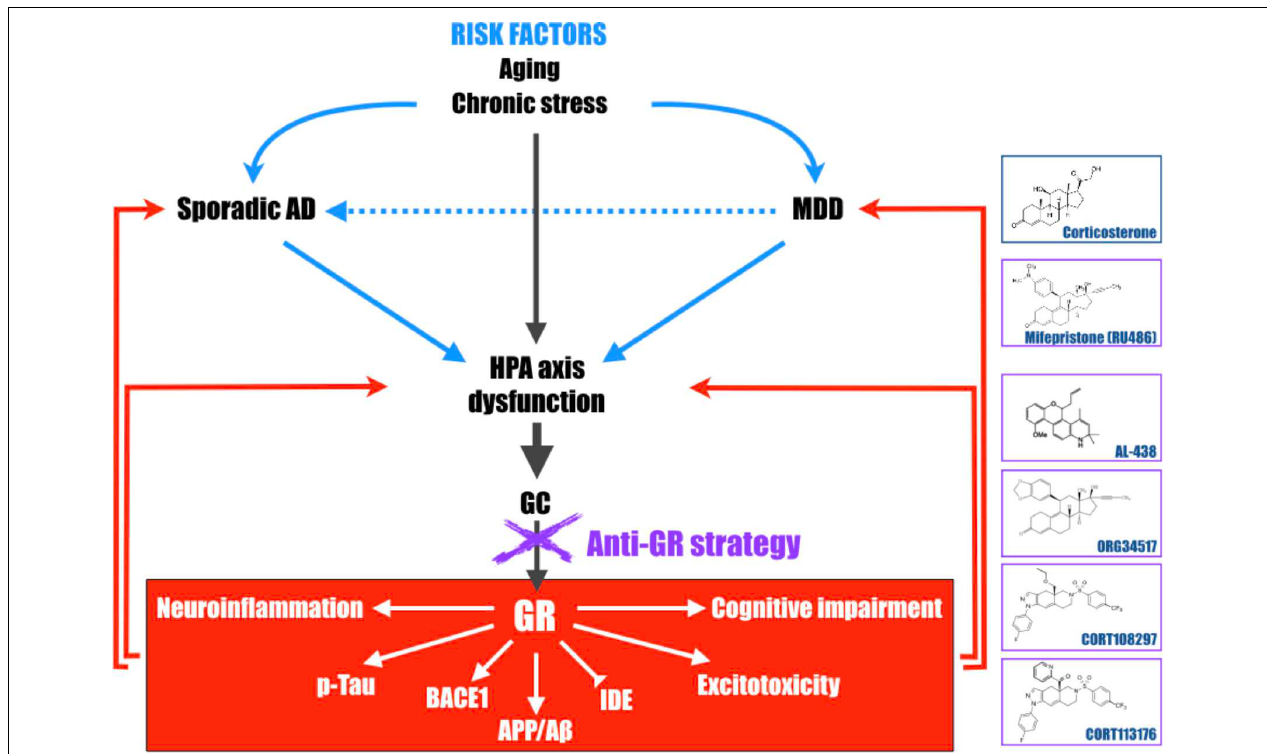
FIGURE 2 | Schematic representation of the central role of the hypothalamic-pituitary-adrenal (HPA) axis dysfunction, GC and GR in the development of major depressive disorder (MDD) and Alzheimer’s disease (AD). Long-term exposure to stress or stress-related disorders (like MDD) contributes to cognitive impairment, A β accumulation, Tau hyperphosphorylation, excitotoxicity, and neuroinflammation processes, leading to development of AD. This schematic representation highlights that pathologies associated with a dysregulation of the HPA axis must be considered, with aging, as important risk factors to develop AD and evidence that therapies aiming at reducing high GC levels upstream, become particularly attractive and relevant in the treatment of the elderly, MDD or early AD patients. Chemical structures of molecules described in this review; corticosterone, mifepristone, AL-438 (Coghlan et al., 2003), ORG34517 (Bachmann et al., 2003), CORT108297, and CORT113176 (Pineau et al.,